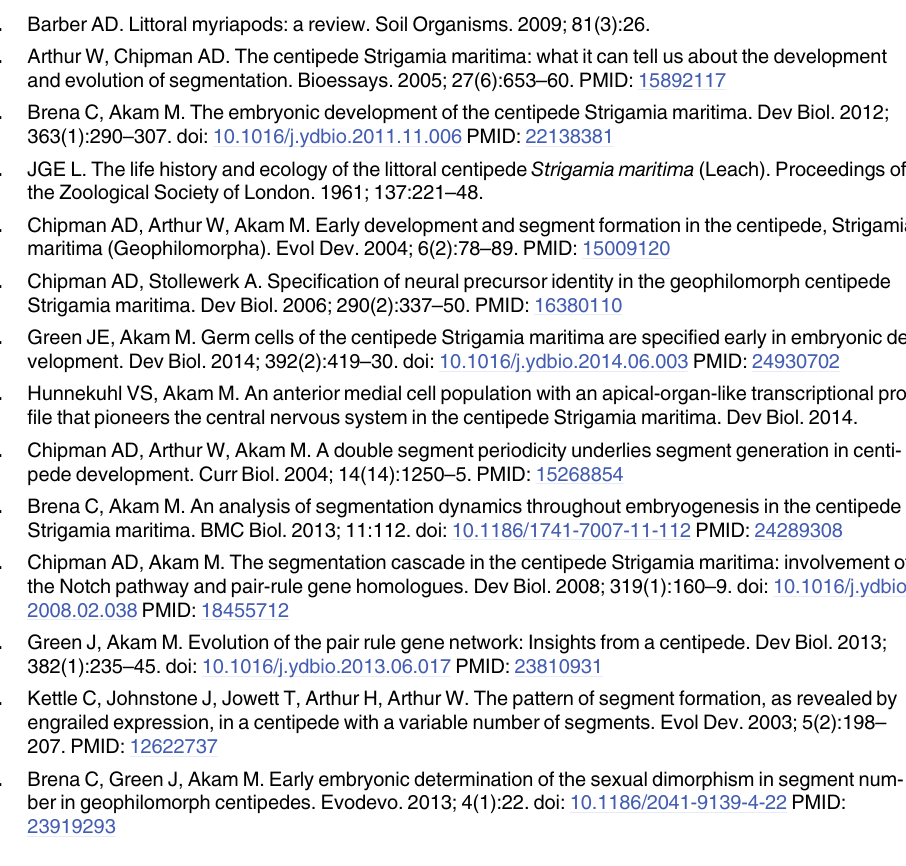
S1 Table. Primer pairs used for amplification of fragments within the mitochondrial ge-